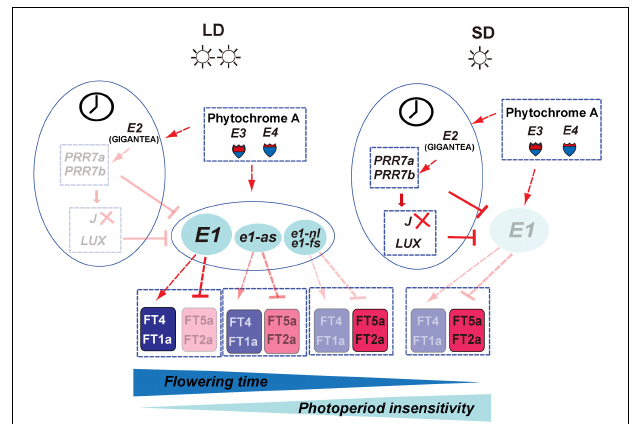
FIGURE 8 | The putative flowering time gene network controlling the photoperiodic sensitivity in soybean. On the left panel, under long-day conditions, the expression of the E1 gene is predominately promoted by the E3 and E4 genes. The elevated E1 expression promotes the FT4a and FT1a expression and represses the FT2a and FT5a , leading to late flowering and higher photoperiod sensitivity. However, leaky allele e1-as displays partial function of the E1 gene, and the non-functional allele, e1-nl or e1-fs , totally loses the promotion activity for the expression of FT4a and FT1a as well as the suppression activity for the expression of FT2a and FT5a . In addition, circadian clock genes such as E2 as well as several downstream components such as PRR3/7a , PRR3/7b , LUX, and J are proven to participate in the control of E1 expression. Under short-day condition, E1 is strongly suppressed and leads to promoted expression of the FT2a / FT5a and early flowering time. The solid and dotted lines, respectively represent direct and indirect regulations. The arrow and T shape represent positive and negative regulation,